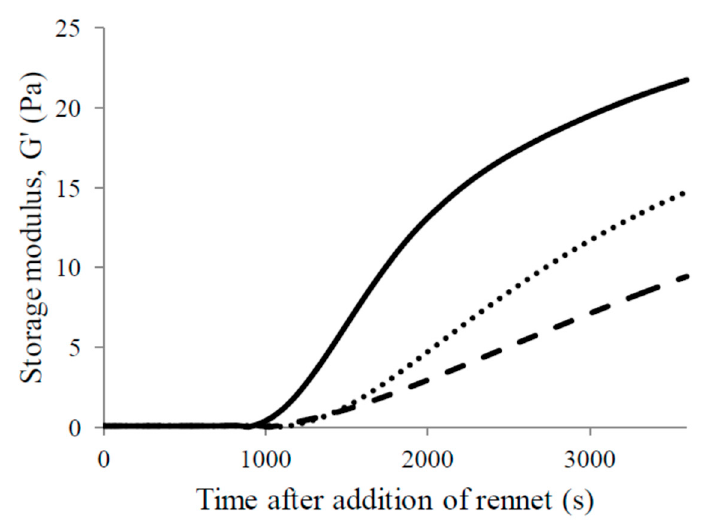
Figure 1. Storage modulus (G’) as a function of time during rennet coagulation of goat milk heated to 65 ◦ C / 30 min (—-), 80 ◦ C / 5 min ( ······ ) and 90 ◦ C / 5 min ( – – ).